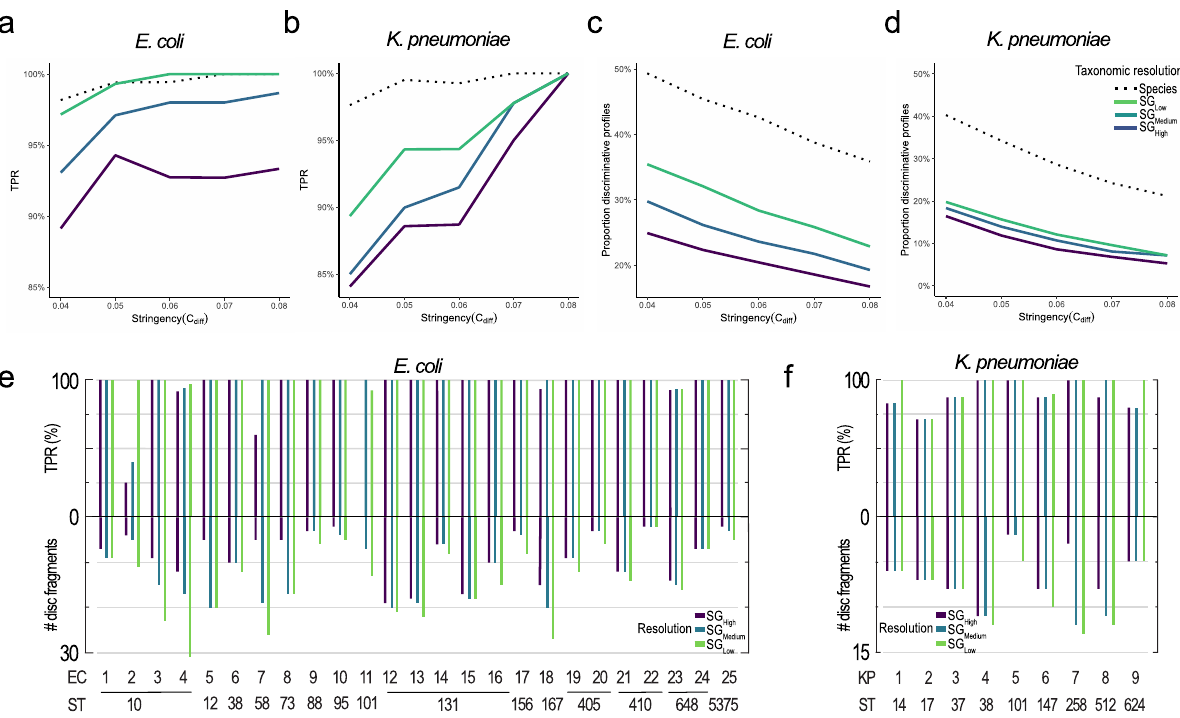
Fig. 2 Parameter evaluation and typing results for pure cultured E. coli and K. pneumoniae isolates. a – d The effects of different fi ltering stringencies (parameter C diff ) on the average true positive rate (TPR) and the average proportion of discriminative pro fi les were assessed using 25 E. coli samples ( a , c ) and nine K. pneumoniae samples ( b , d ). The method was evaluated on the three investigated strain-level taxonomic resolutions – SG Low , SG Medium and SG High – as well as on the species level. e The number of discriminative intensity pro fi les and true positive rate (TPR) for each cultivated pure E. coli sample for the three investigated taxonomic resolutions, SG High , SG Medium and SG Low . f The number of discriminative intensity pro fi les and true positive rate (TPR) for each cultivated pure K. pneumoniae sample for the three investigated taxonomic resolutions, SG High , SG Medium and SG Low